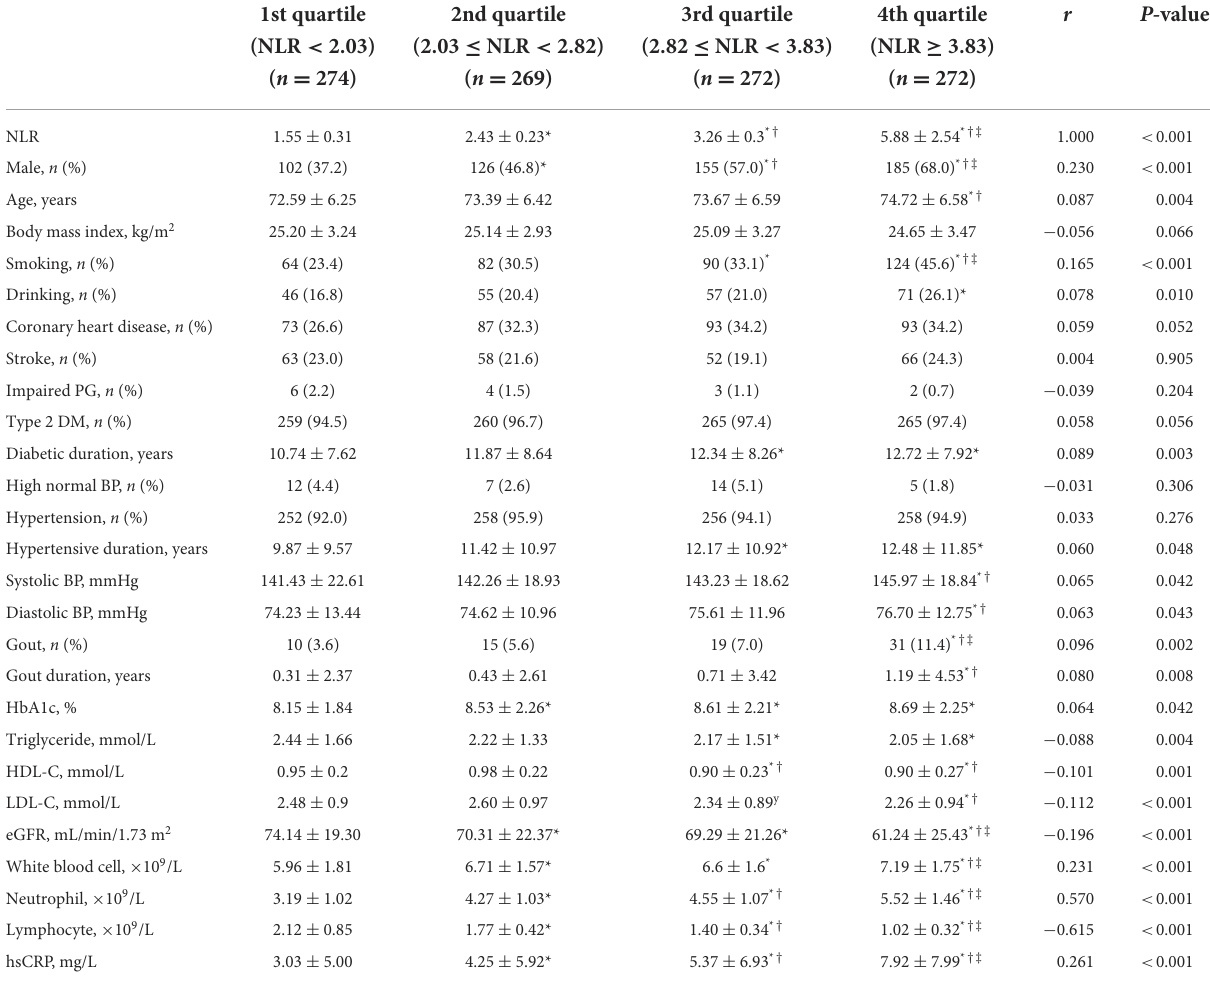
TABLE 1 Comparison of clinical characteristics among quartile NLR